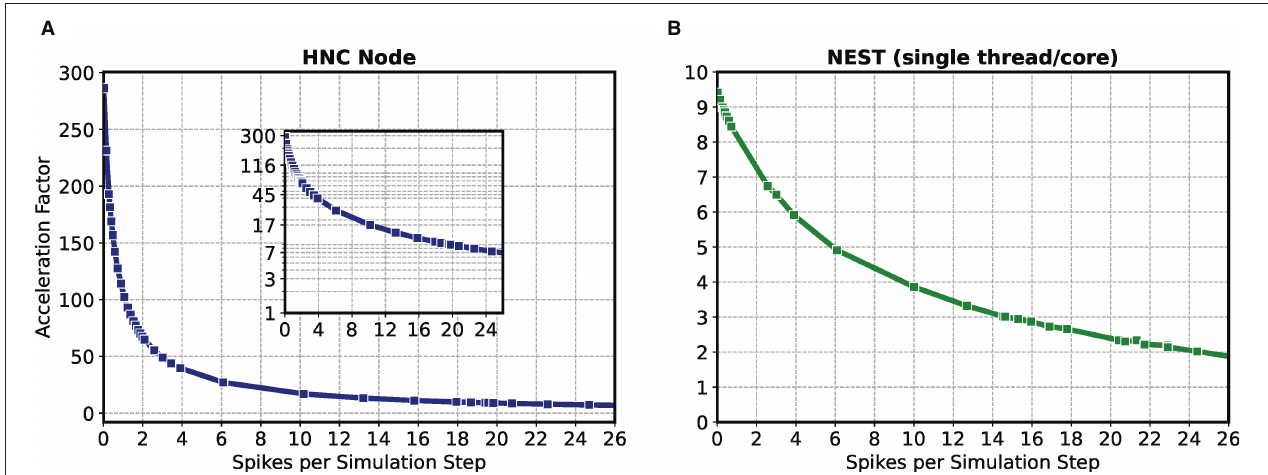
FIGURE 2 | Performance as a function of workload for the HNC node and NEST. The acceleration factor (wall clock time divided by the biological time) as a function of the average number of spike events per simulation time step ¯ ν k of the HNC node using a PL clock frequency of f clk = 200 MHz (A) and the neural simulation tool NEST on an Intel(R) Core(TM) i7-7700K CPU 4.20 GHz (Kaby Lake architecture) (B) . The measurements were carried out with h = 0.1 ms simulation resolution. In consecutive simulation runs of 5 min simulated biological time, the 1,000 neuron two-population Izhikevich neural network model described in Section 5.3 was stimulated with an increasing external offset current i ext = {− 3.0 pA,.., + 100 pA } . Inset in (A) gives a log-lin representation.